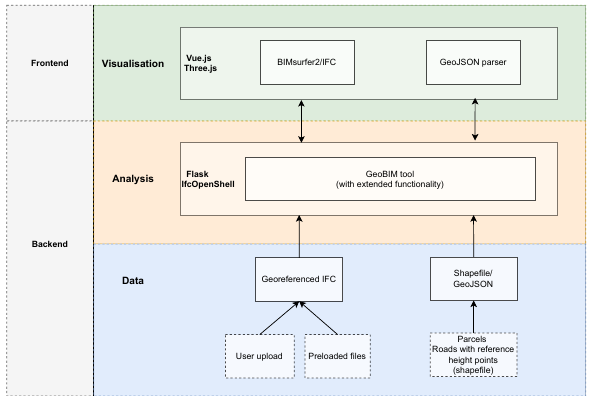
Figure 2. The architecture of the web-based